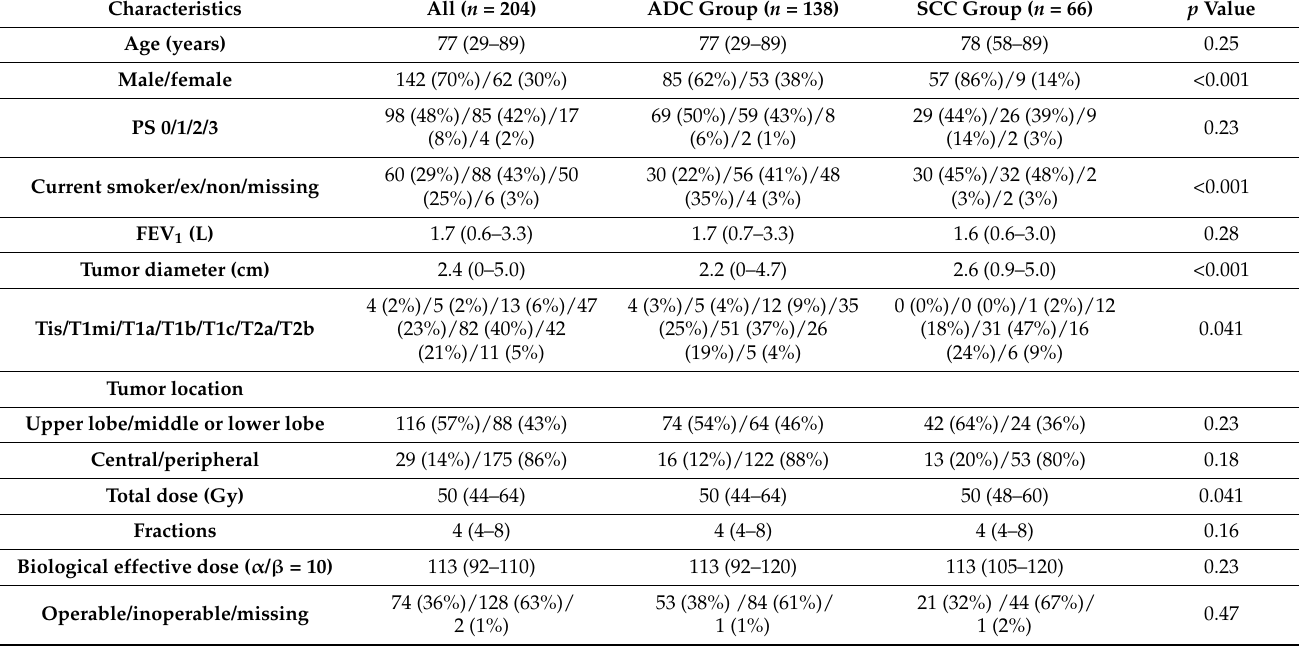
Table 1. Patient and treatment